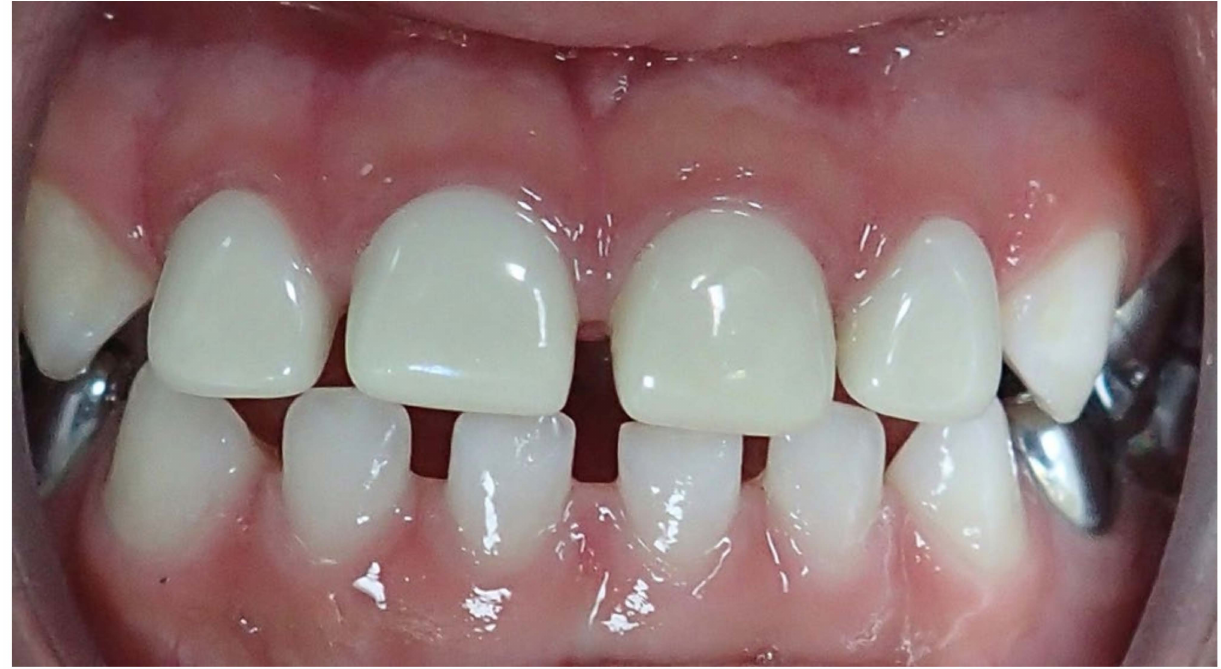
Figure 1. Restoration of four anterior teeth with pulp therapy on one tooth. Parent rated teeth 52, 51, 61, 62 as “slight mismatch from adjacent teeth”. Crown contour was “nicely contoured and natural looking”. Dentists rated teeth 52, 51 as “slight shade mismatch” and 61, 62 as “no noticeable difference from adjacent teeth”. Tooth 51 had a pulpotomy. Dentists rated 52 crown contour as “acceptable but could have been contoured better, perhaps longer, shorter, wider, thinner. Teeth 51, 61, 62 “appear very cosmetic, nicely contoured and natural looking.